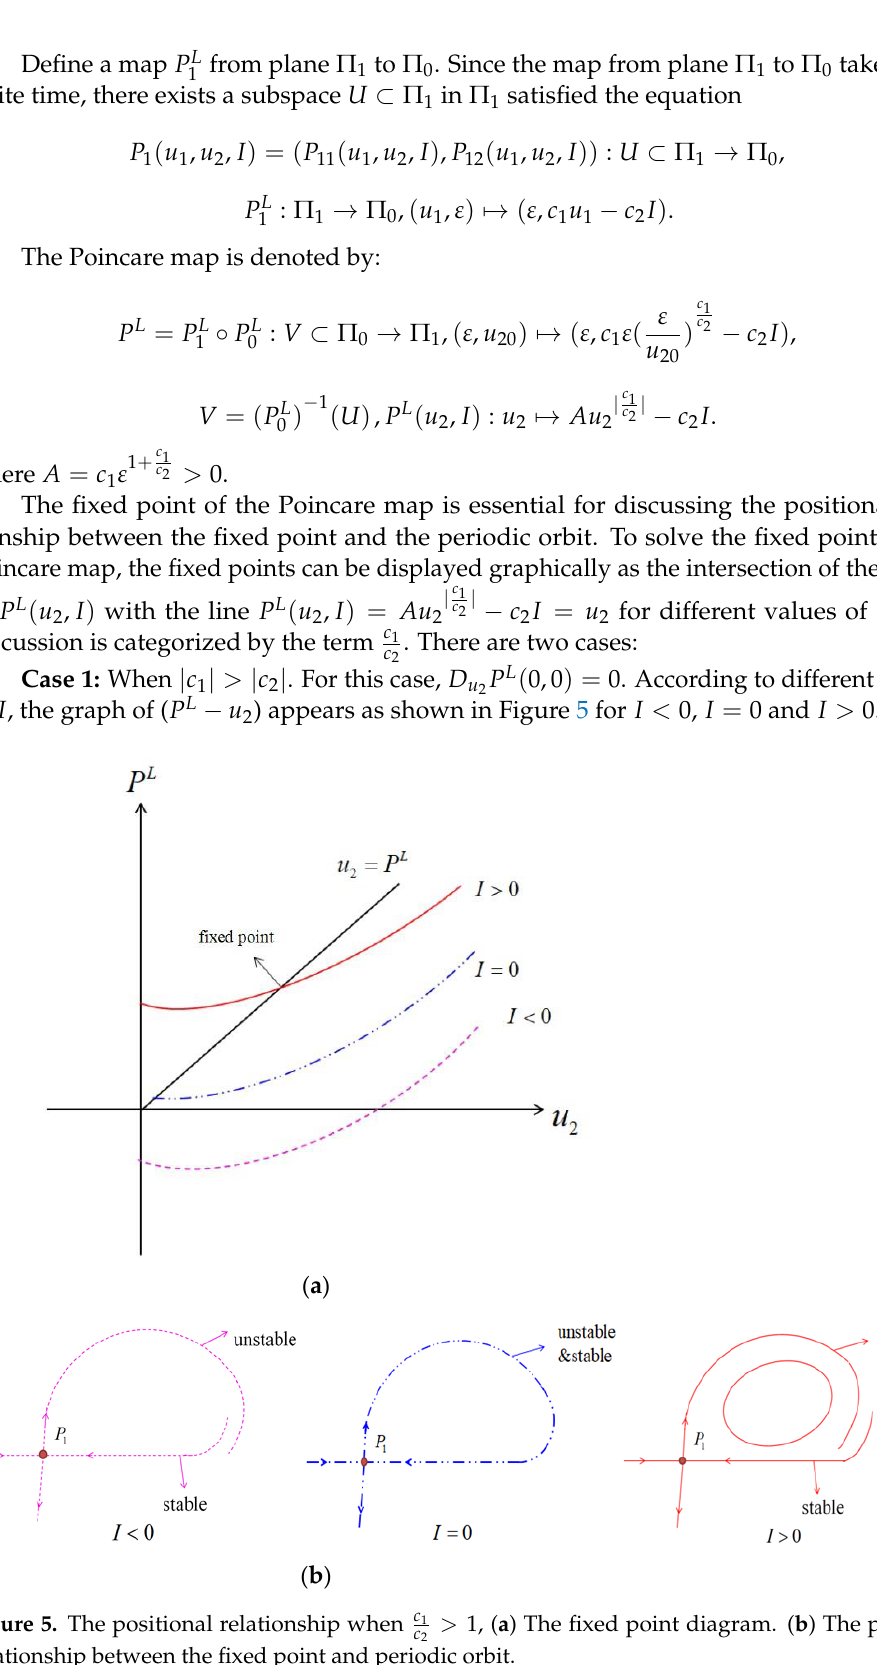
Figure 5. The positional relationship when c 1 relationship between the fixed point and periodic orbit.